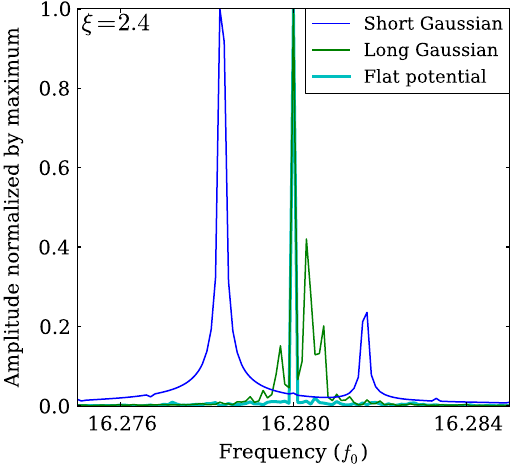
FIG. 6. Fourier transform of the three non-Gaussian distribu- tions listed in Table II compared to a Gaussian distribution and the distribution expected for the flat potential condition.